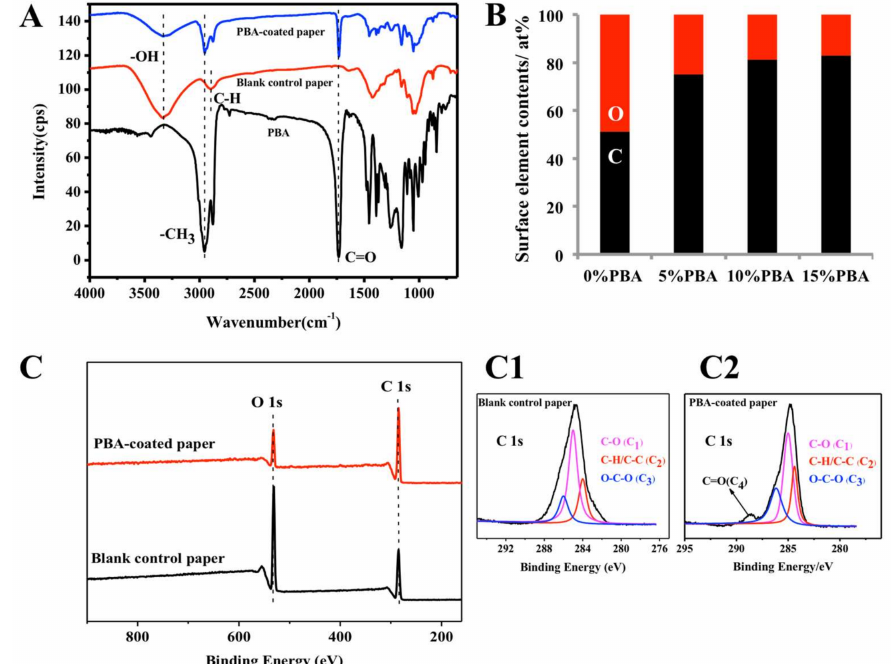
Figure 2. ( A ) ATR-FTIR spectra of the PBA-coated paper (10%) (blue line) and the blank control paper (red line), as well as the FTIR spectrum of the PBA (black line). ( B ) The EDS measurements of surface C/O ratios of the blank control paper and papers coated with 5, 10 and 15% of PBA, respectively. ( C ) XPS survey spectra of the blank control paper and the PBA-coated paper (10%). XPS curve fitting of the C 1s photoelectron peak of blank control paper ( C1 ) and PBA-coated paper (10%) ( C2